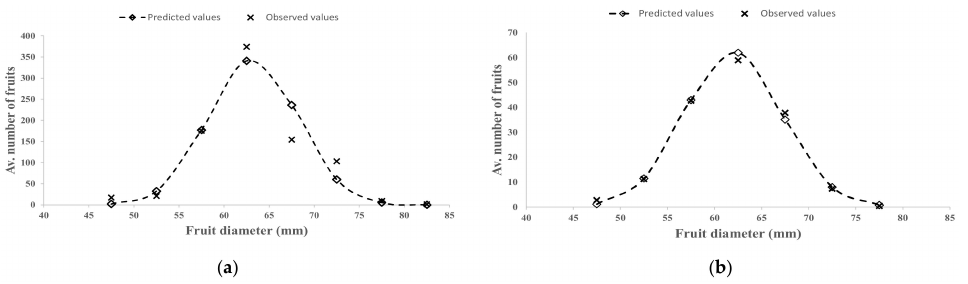
Figure 3. Example of the agreement between the predicted and observed fruit-size distribution, expressed as fruit diameter, from apple ( a ) and pear ( b ) experiments. The average fruit diameters of the samples, as used in this example, were between 65 and 70 mm for apple samples and between 60 and 65 mm for pear samples. Table 5. Statistics of the predicted versus observed number of fruits in fruit-size classes. Class boundaries are the maximum fruit diameters in millimeters 1 .